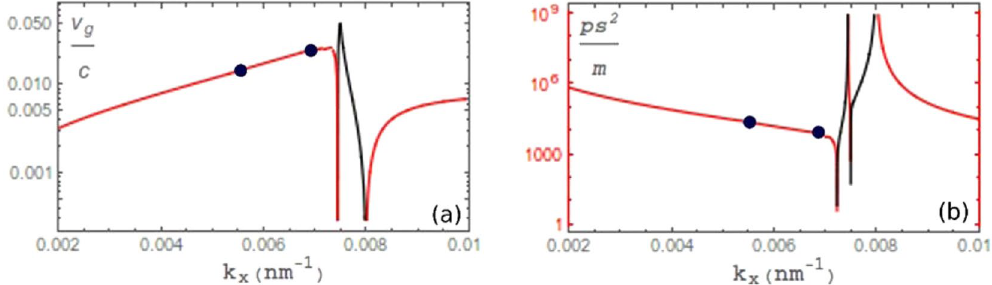
Figure 4. ( a ) Absolute value of the group velocity of the FB mode with negative values of the group velocity in gray (red online) and positive values in black. ( b ) Absolute value of the GVD is shown with transitions between normal (red online, gray) and anomalous dispersion (black). PAR points are